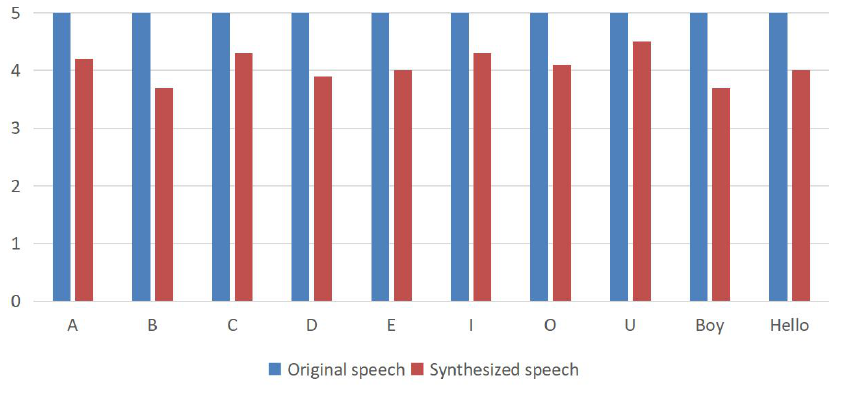
Figure 12. mean opinion score (MOS) results of synthesized